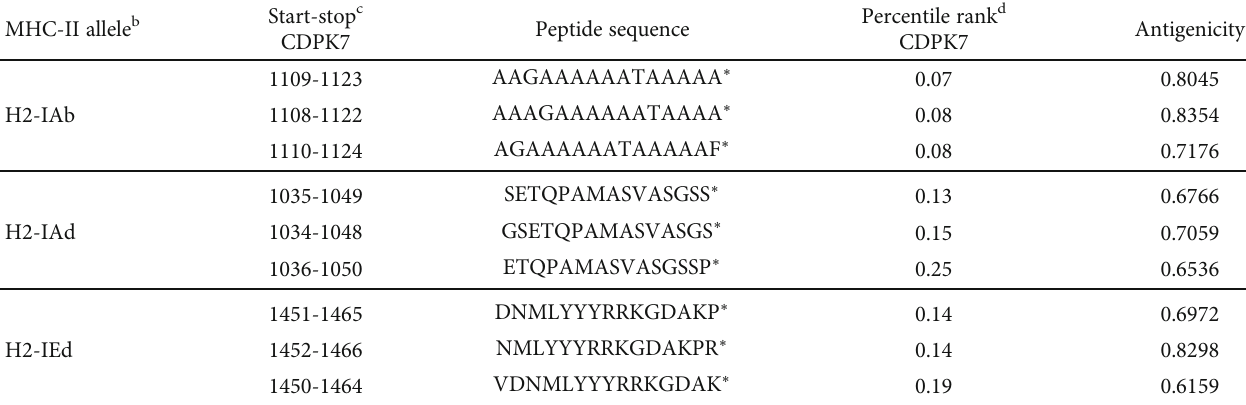
Table 6: IC values for CDPK7 binding to MHC class II molecules obtained using the IEDB a . 50 MHC-II allele